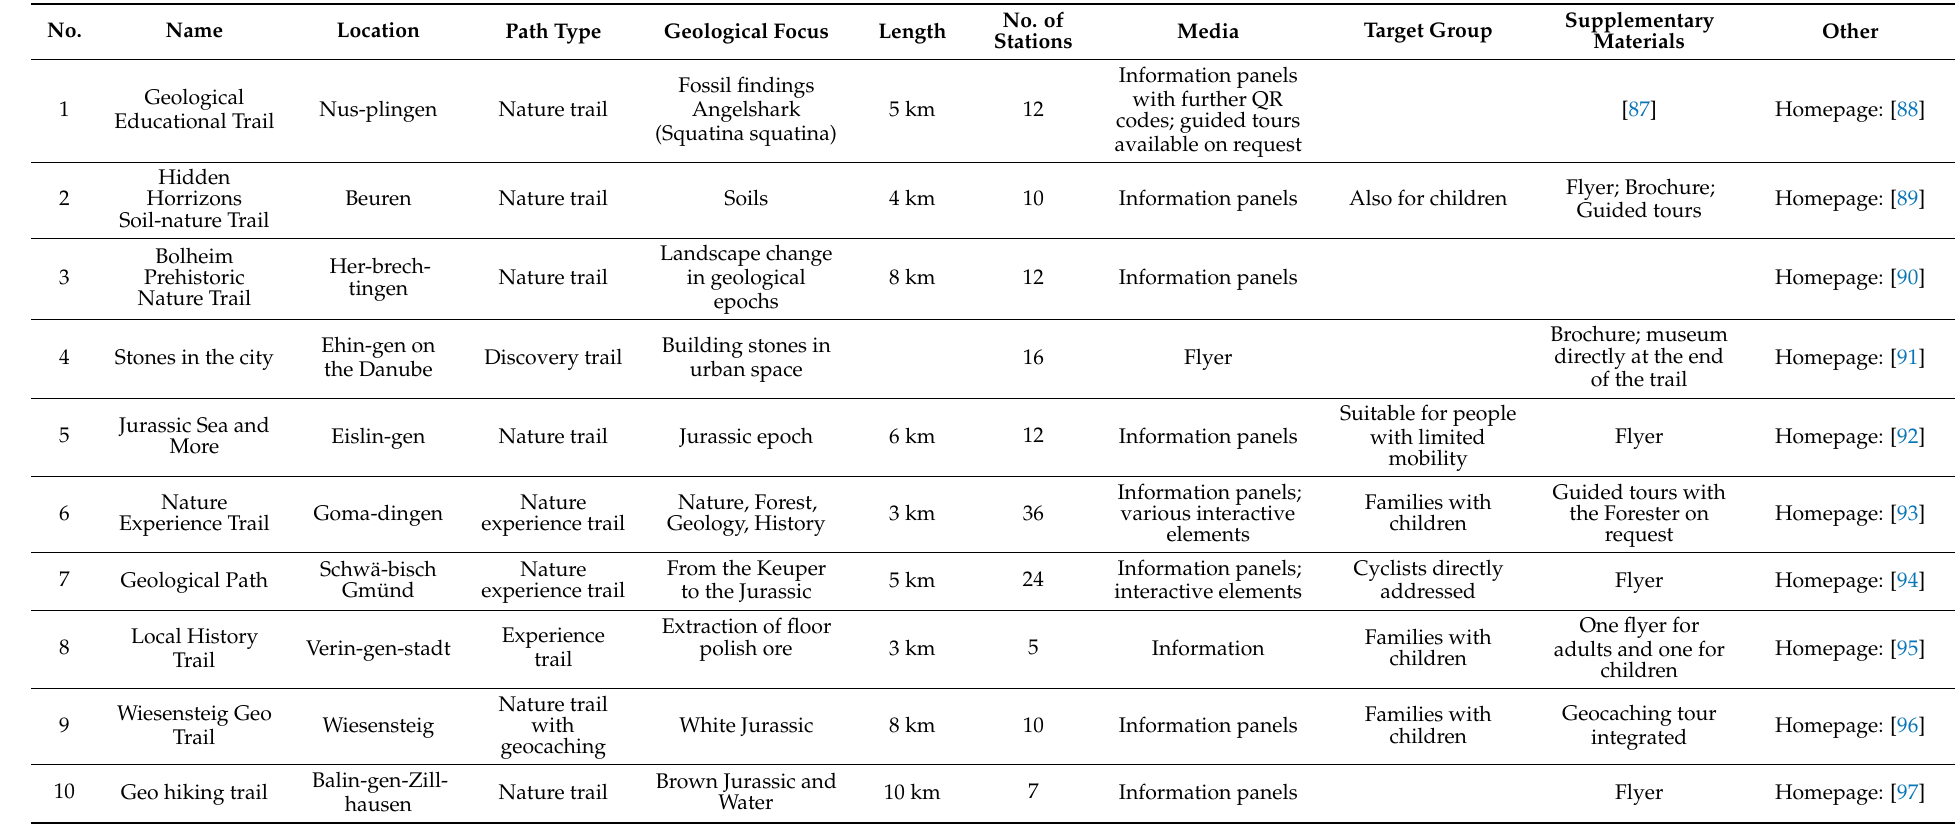
Table 2. Trails selected for detailed analysis in UGGp Swabian